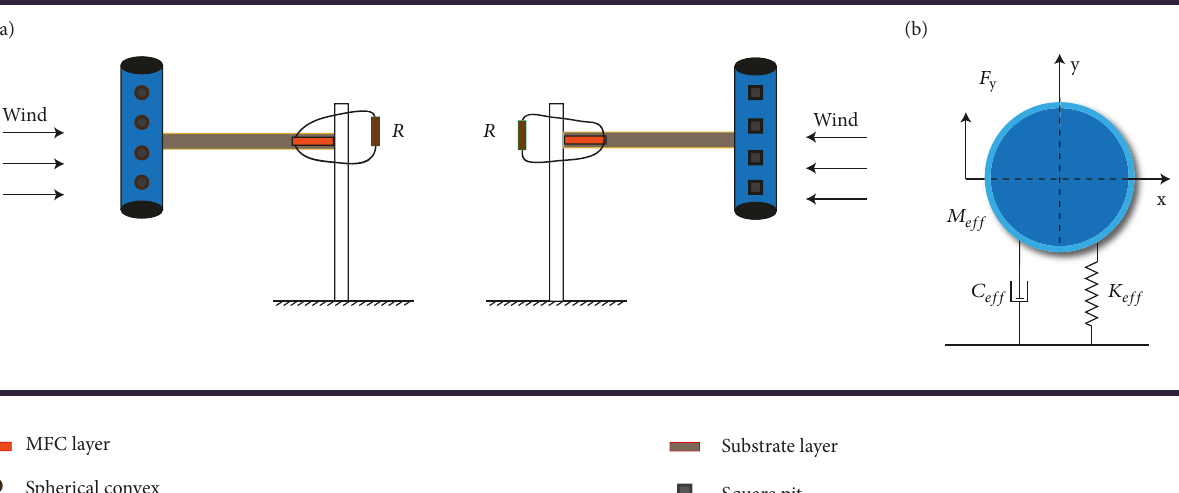
Figure 2: Schematic diagram of VIVPEH with bionic structure: (a) physical diagram in the wind tunnel test; (b) equivalent schematic